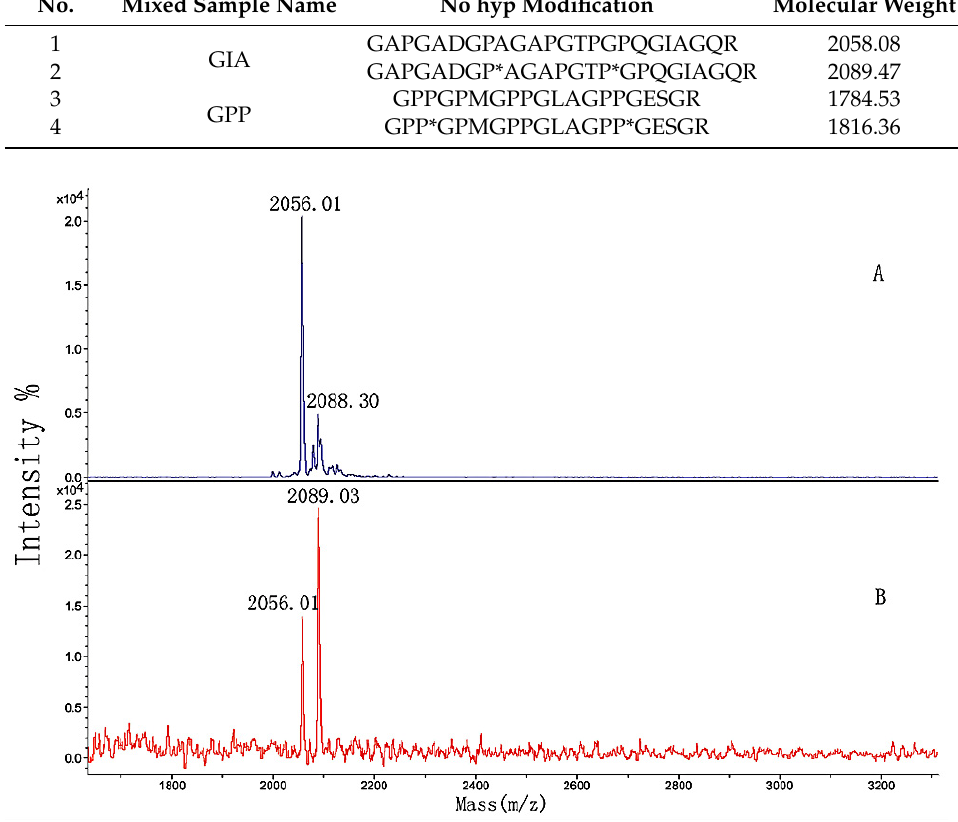
Figure 12. MALDI-TOF MS spectra of ( A ) GIA sample and ( B ) the elution solution.